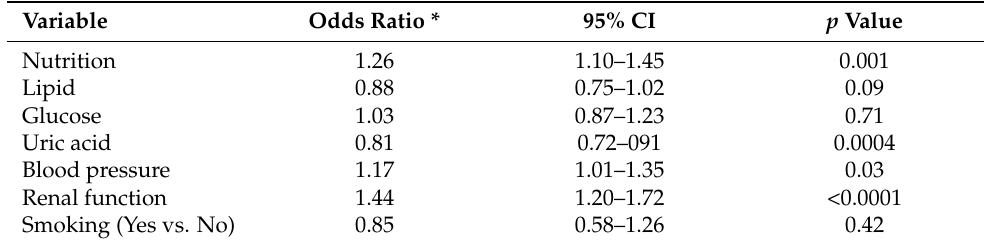
Table 7. Estimates of odds ratio from ordinal logistic regression model.